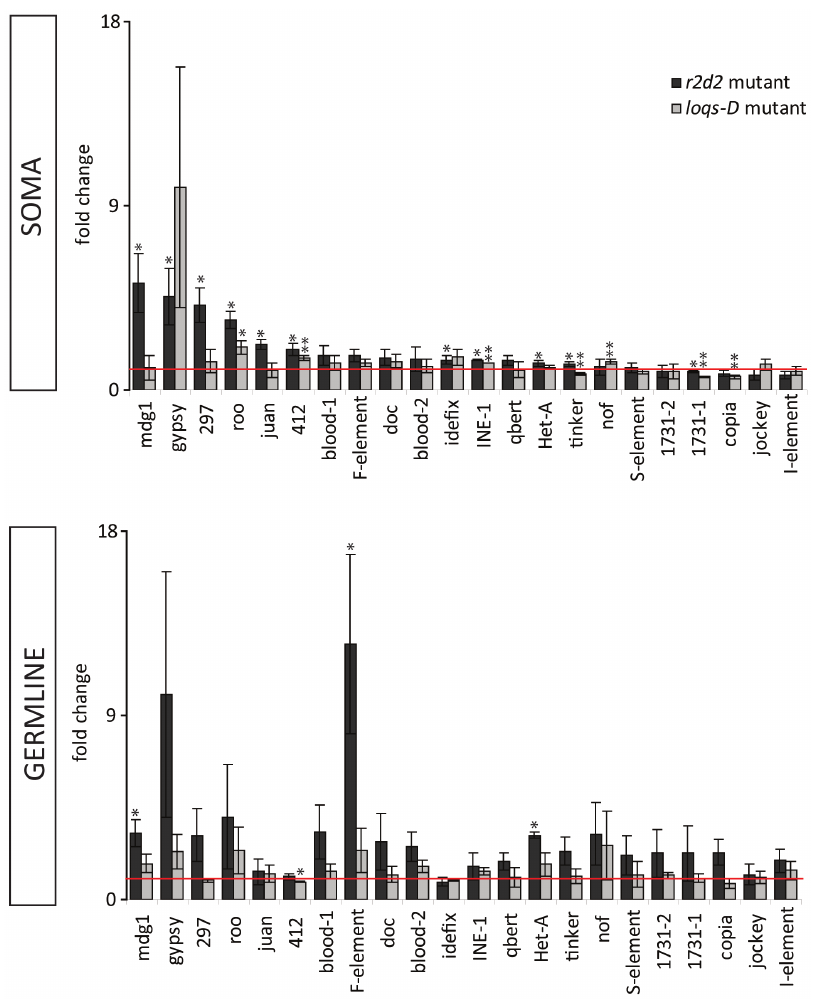
Figure 5. Analysis of steady state level of transposons by qRT-PCR. RNA was isolated from heterozygous and homozygous r2d2 and loqs-D mutants. DNA was digested with DNase I, the RNA was reverse transcribed and used for transposon profiling by qRT-PCR. Each transposon was normalized to the average of rp49 and gapdh controls and depicted as the fold change of homozygous to heterozygous mutant in soma and germline, respectively (p , 0.05(*), p , 0.009(**) student’s T-test, n=3).